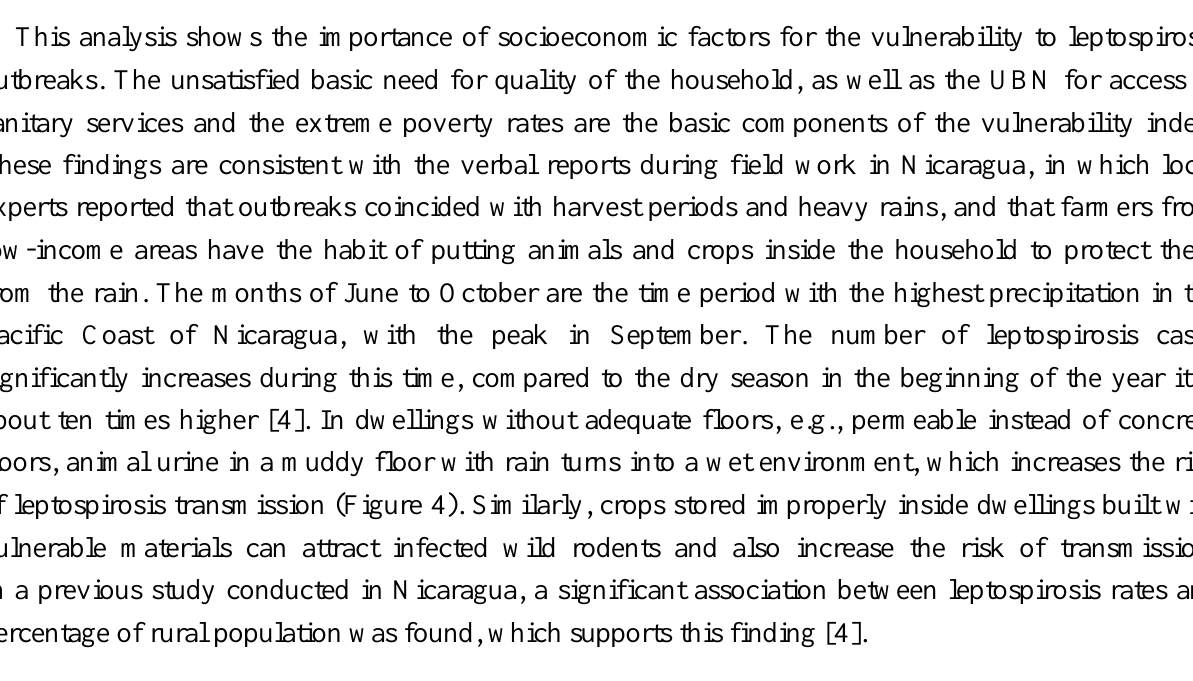
Figure 4. Typical household of low-income rural area in Nicaragua.